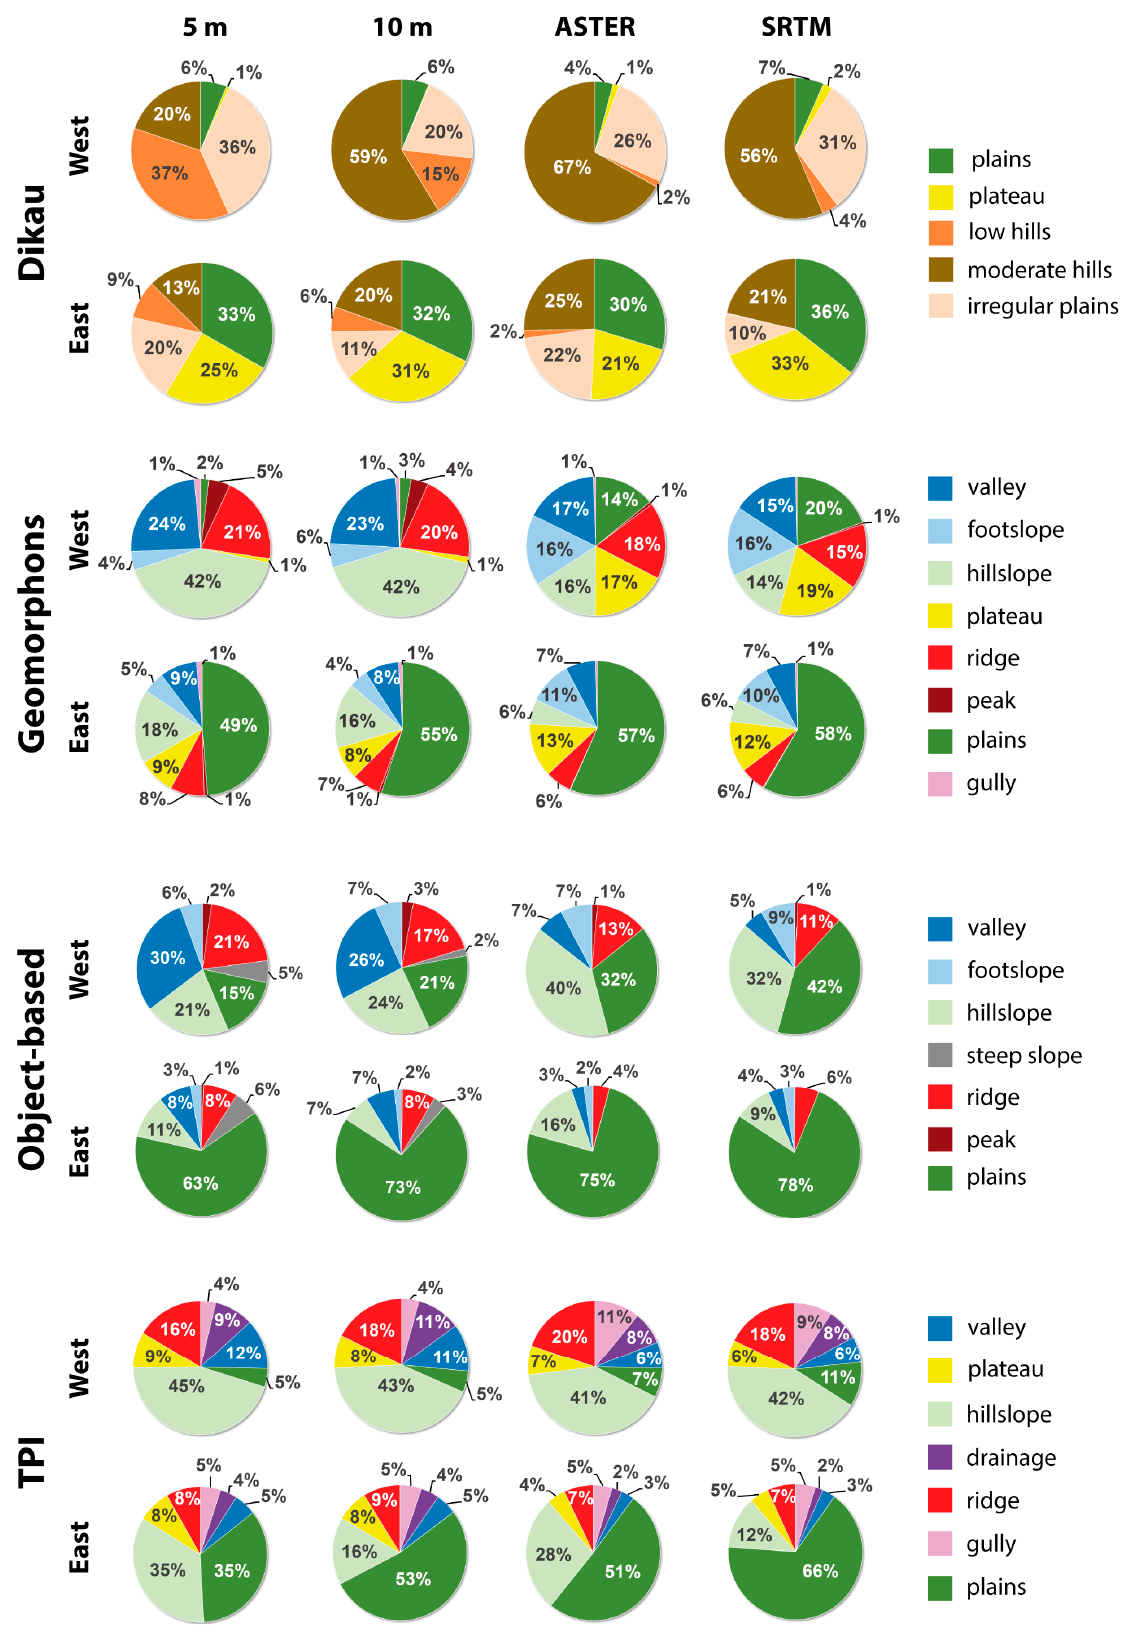
Figure 3. Percentage distribution of landform classes for each approach, area and pixel resolution. Hills are the predominant landforms of the western study area. Therefore, all approaches classified the majority of pixels correctly into landforms, which represent hilly landforms. The